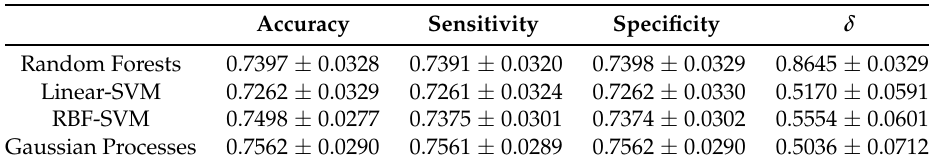
Table 9. AUC, accuracy, sensitivity and specificity related to the dark-lesion detection (microaneurysms and hemorrhages) on DIARETDB1 database. Results were optimized to the best sensitivity-specificity trade-off.